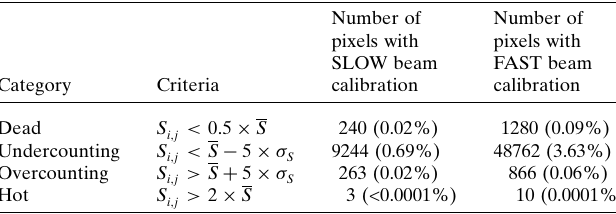
1 = 2 is shown as the ’ S S i ; j i ; j